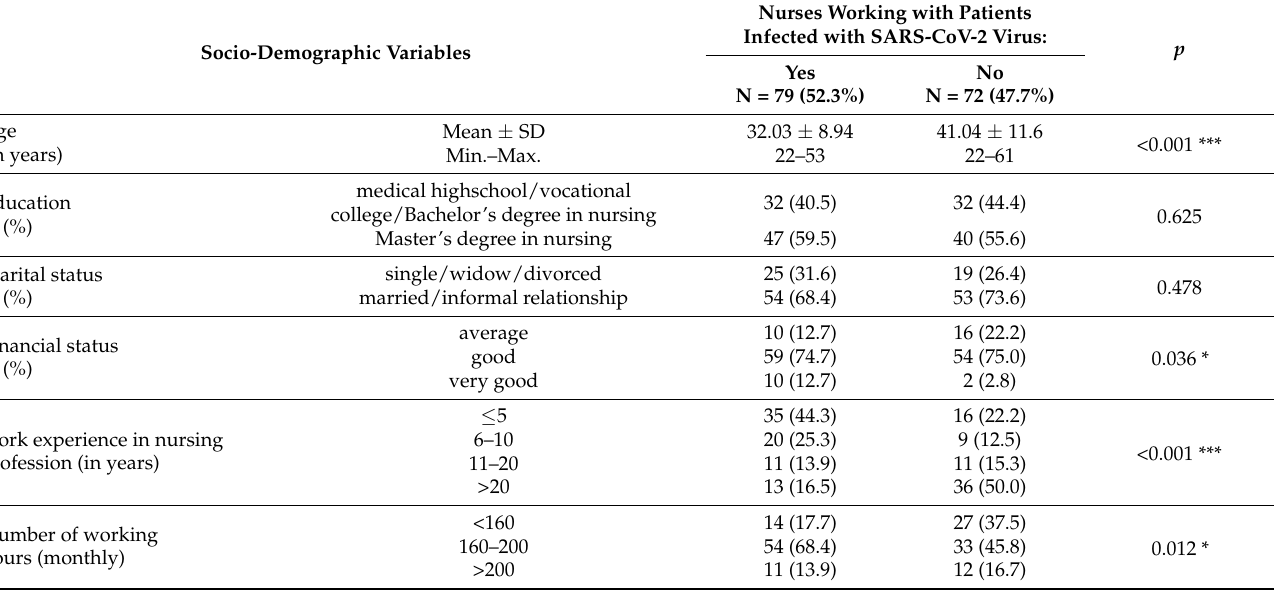
Table 1. Socio-demographic characteristics of nurses working with patients infected and those working with patients not infected with the SARS-CoV-2